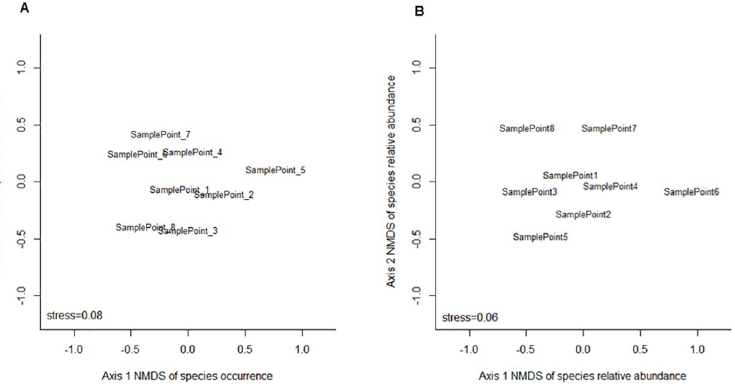
Fig 6. NMDS analysis of occurrence and abundance of sand flies in relation to sampling points. A) Plot for NMDS of occurrence data. B) Plot for NMDS of relative abundance data.